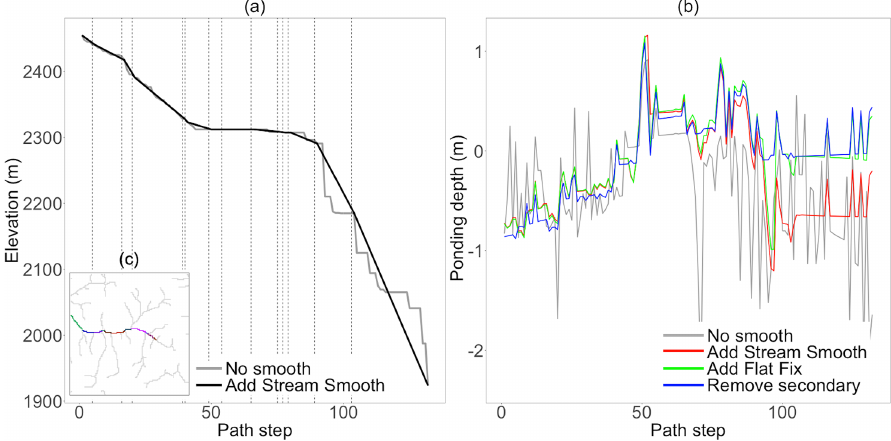
Figure 9. (a) The elevation along an example stream segment (shown in panel c ) before and after smoothing applied along the stream; the stream is divided into segments by dashed lines; (b) the ponding depth along the main stem from the runoff tests with four slope cases; (c) the main stem with segments plotted by different colors